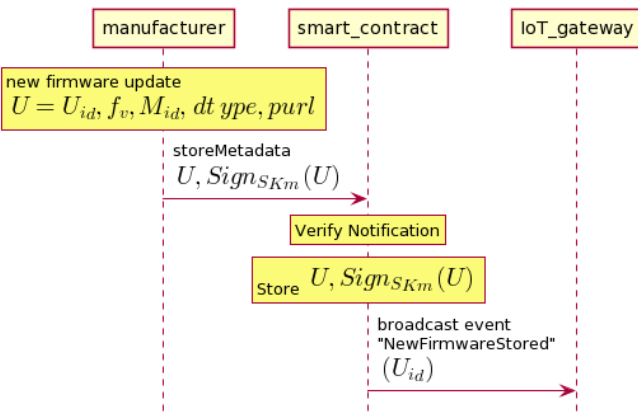
Figure 3. Creation of the firmware update smart